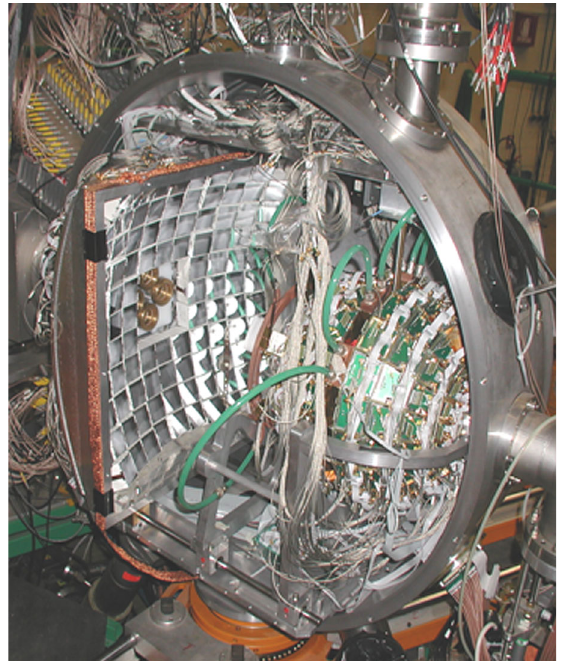
FIG. 16. The prototype ion collection device constructed for Beta Beam